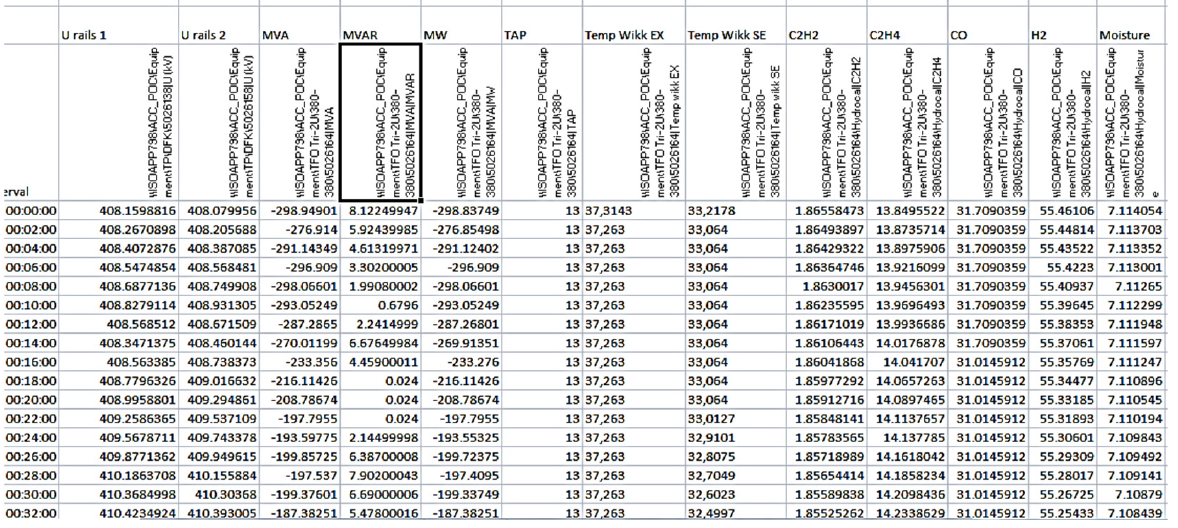
Figure 20. Online data is listed in a “sheet” sampled every 2 min.